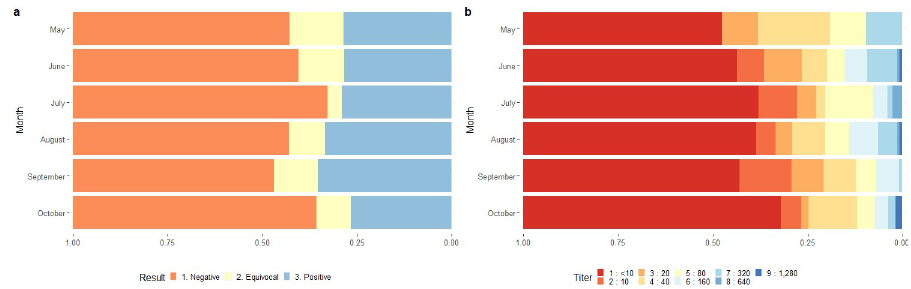
Fig 5. Frequency of ZKV-specific IgG and nAb titer in pregnant women by month. Sera of all participants were screened for ZKV-specific IgG and nAb titer. ZKV-specific IgG (a) and nAb titer (b) were separate by month.